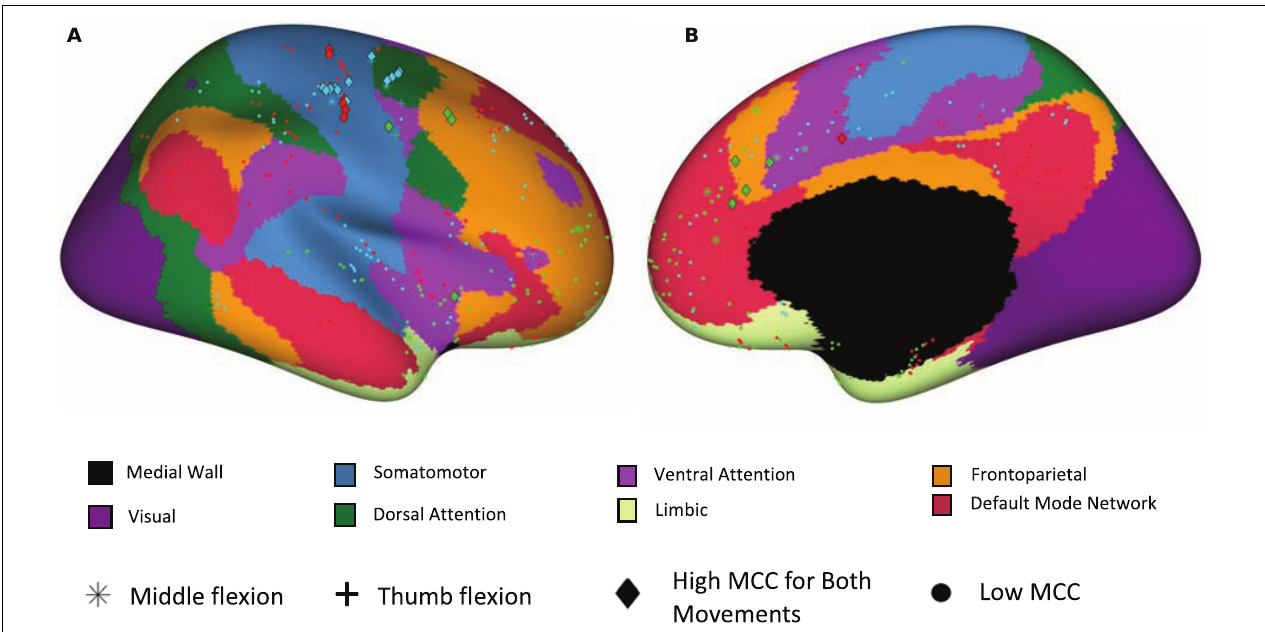
FIGURE 8 | Electrode site locations with respect to functional networks for participants P1_01 (red), P2_02 (green), and P3_01 (blue). (A) Sagittal view from lateral perspective. (B) Sagittal view from medial perspective. TABLE 1 | Decoding performance (mean ± SD) for sustained hand movements when using a recurrent neural network (LSTM type) with repeatability-based feature selection. Participant Open-close hand Thumb-middle flexion SEEG HD ECoG SEEG HD ECoG